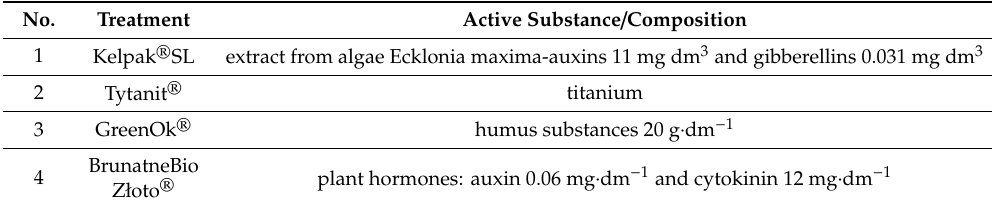
Table 2. Factor II—Description of biostimulants applied in the experiment